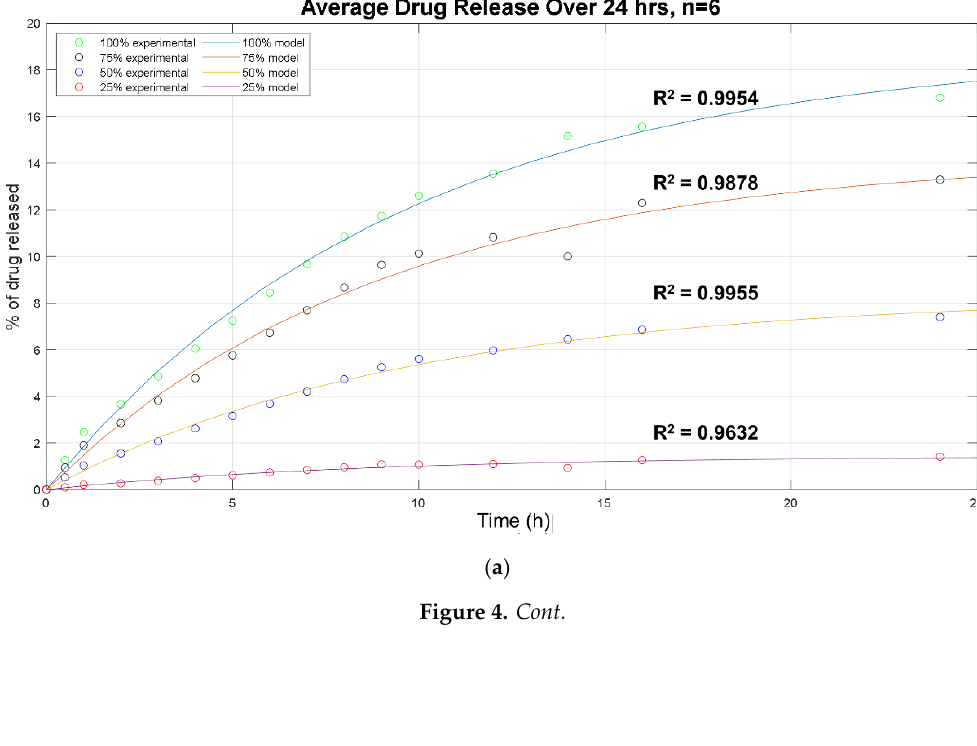
Figure 3. Comparative release profiles based on formulation (PVA (square), NFC/PVA (circle), TNFC/PVA (triangle)) for different initial acetaminophen concentrations: ( a ) 14.0 mg/mL, ( b ) 10.5 mg/mL, ( c ) 7.0 mg/mL, ( d ) 3.5 mg/mL.